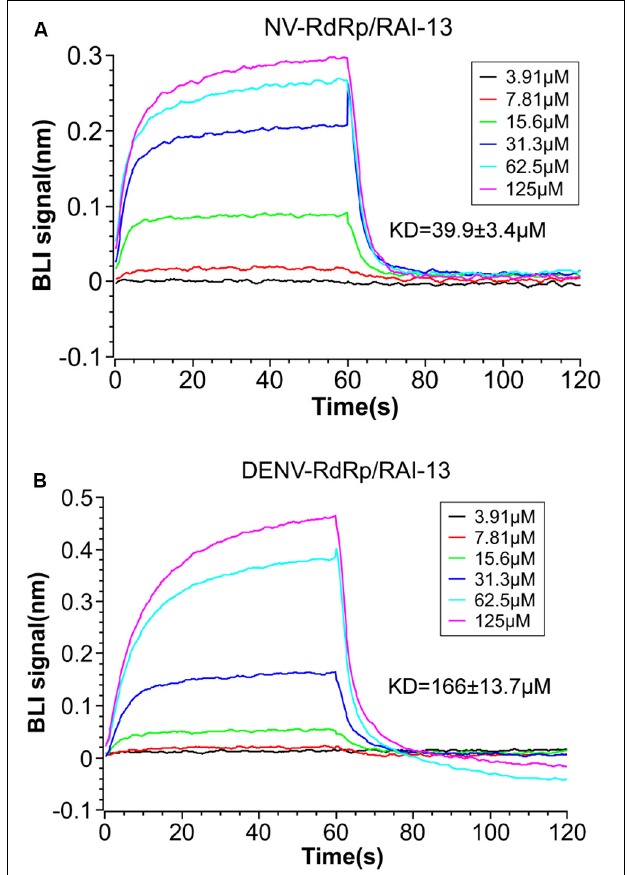
FIGURE 7 | Structural properties of RAI-13 bound to DENV or hNV RdRps during MD simulation over 10 ns. (A) Root-mean square deviation (RMSD) values for the backbone atoms. Black and red lines represent complexes of DENV and hNV RdRps, respectively. (B) Superimposition of the most representative complex structures of DENV and hNV RdRp bound with RAI-13. The ligand is shown as magentas and orange sticks, respectively. The priming loop in DENV RdRp and C-terminal in hNV RdRp are highlighted in yellow and green loops,